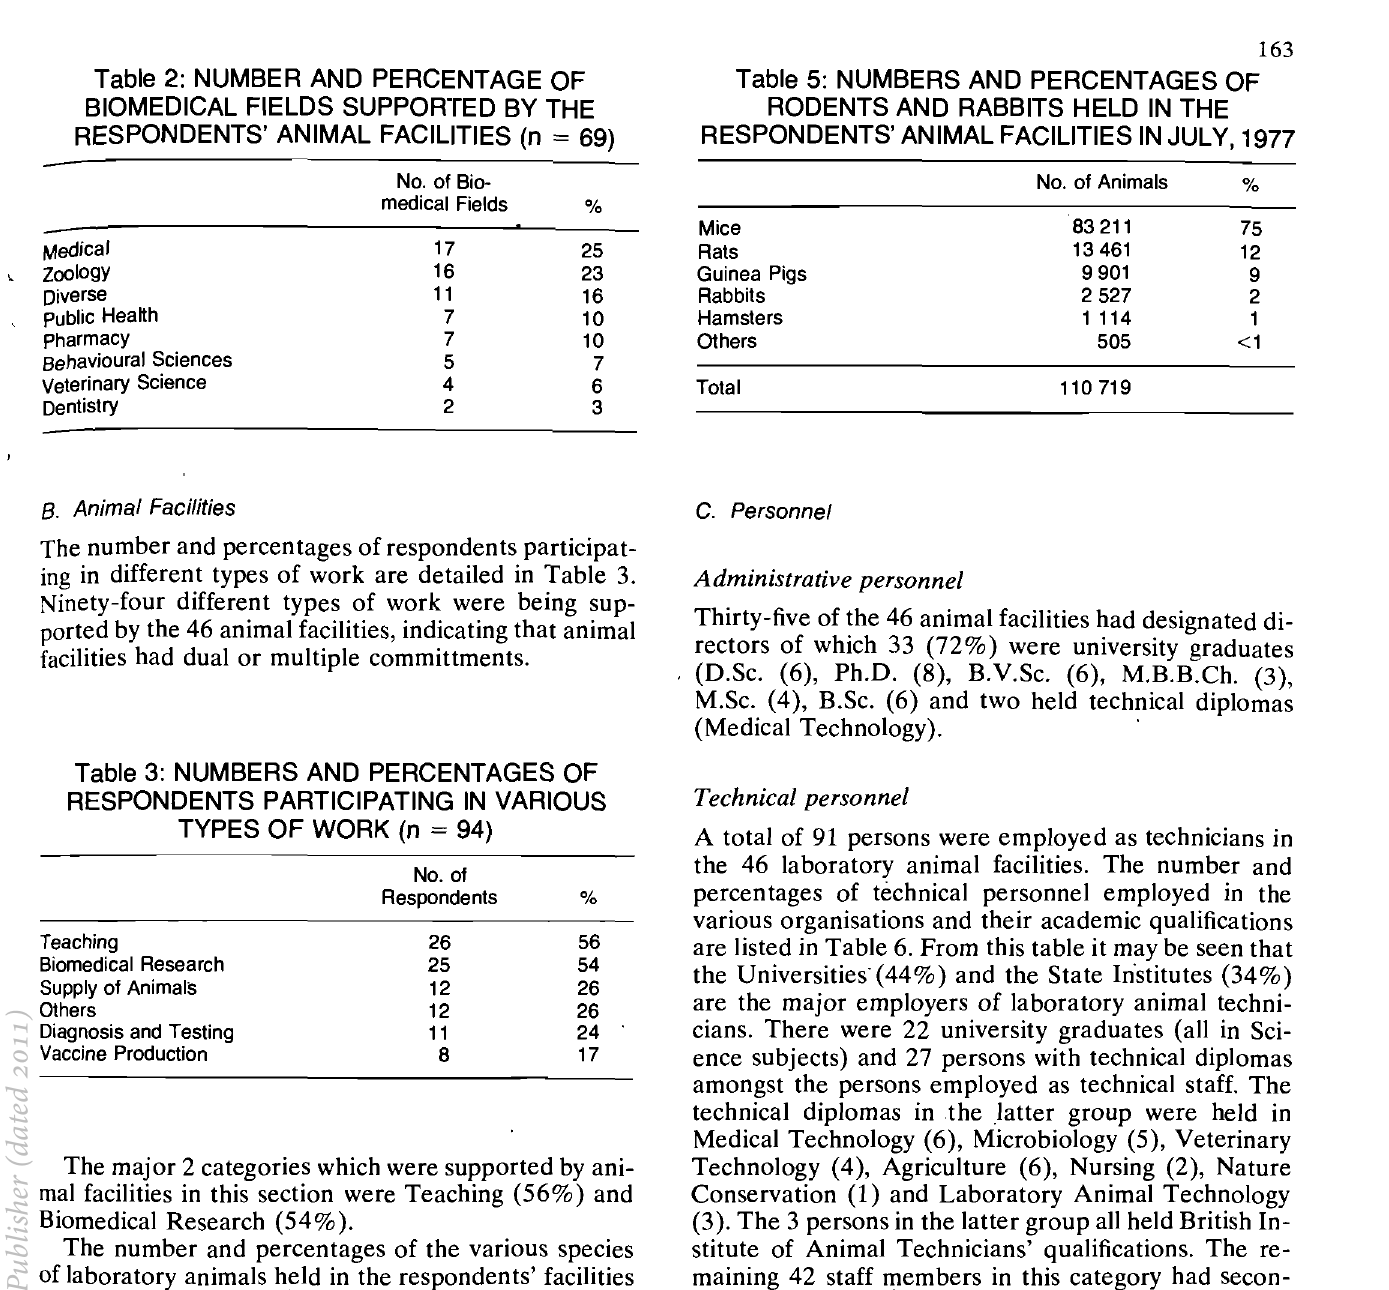
Table 4: NUMBERS AND PERCENTAGES OF LABORATORY ANIMALS HELD IN THE RESPONDENTS'